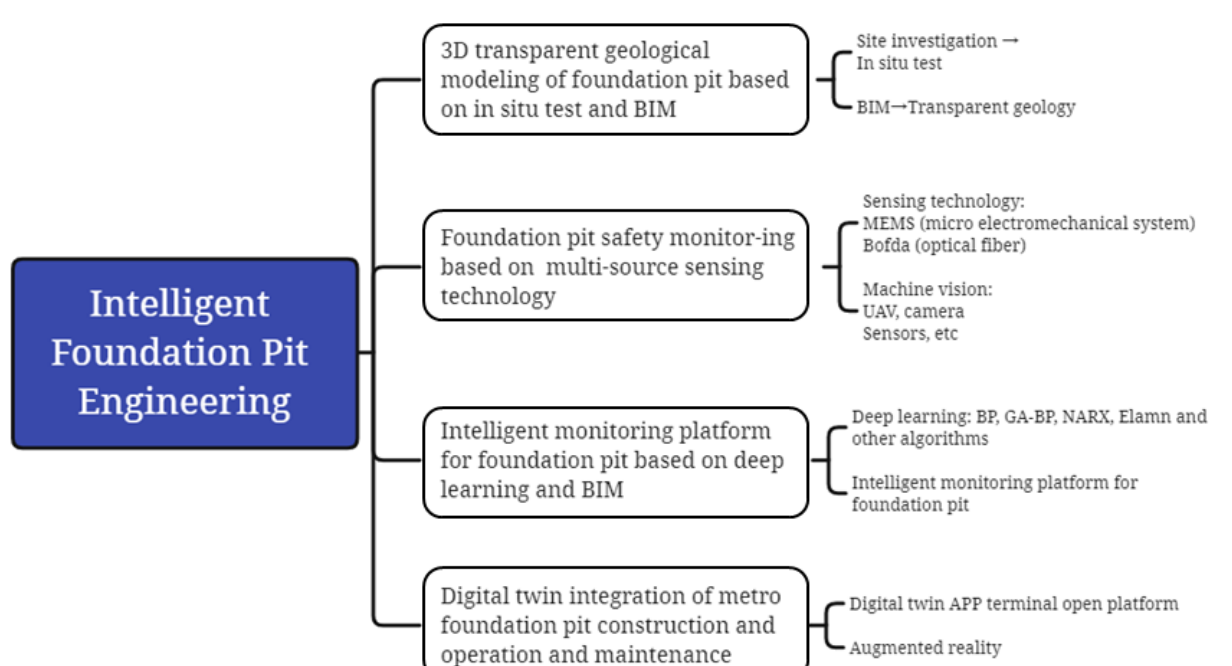
Figure 2. Implementation path of intelligent foundation pit engineering.